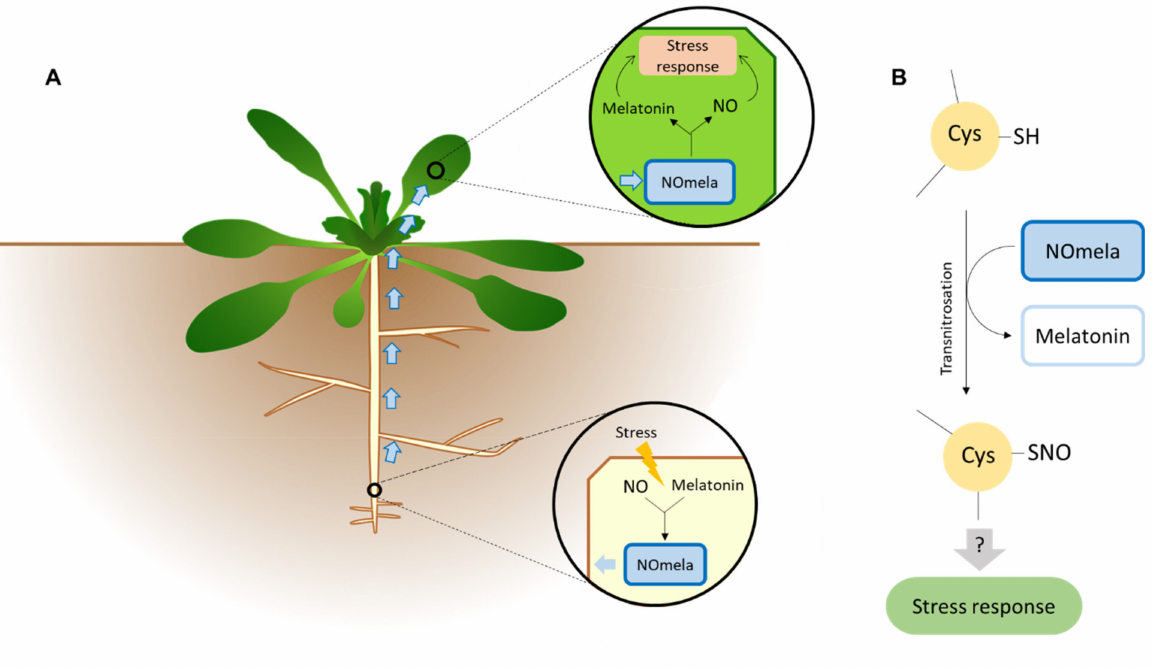
Figure 4. ( A ) Proposed mechanism for NO and MEL transport from roots to aerial parts via NOmela synthesis during stress conditions. Stress induces NOmela formation from NO and MEL, which can be transported to aerial parts, where it breakdowns into NO and MEL for triggering stress responses; ( B ) proposed mechanism for NOmela-mediated molecules transnitrosation mechanism under